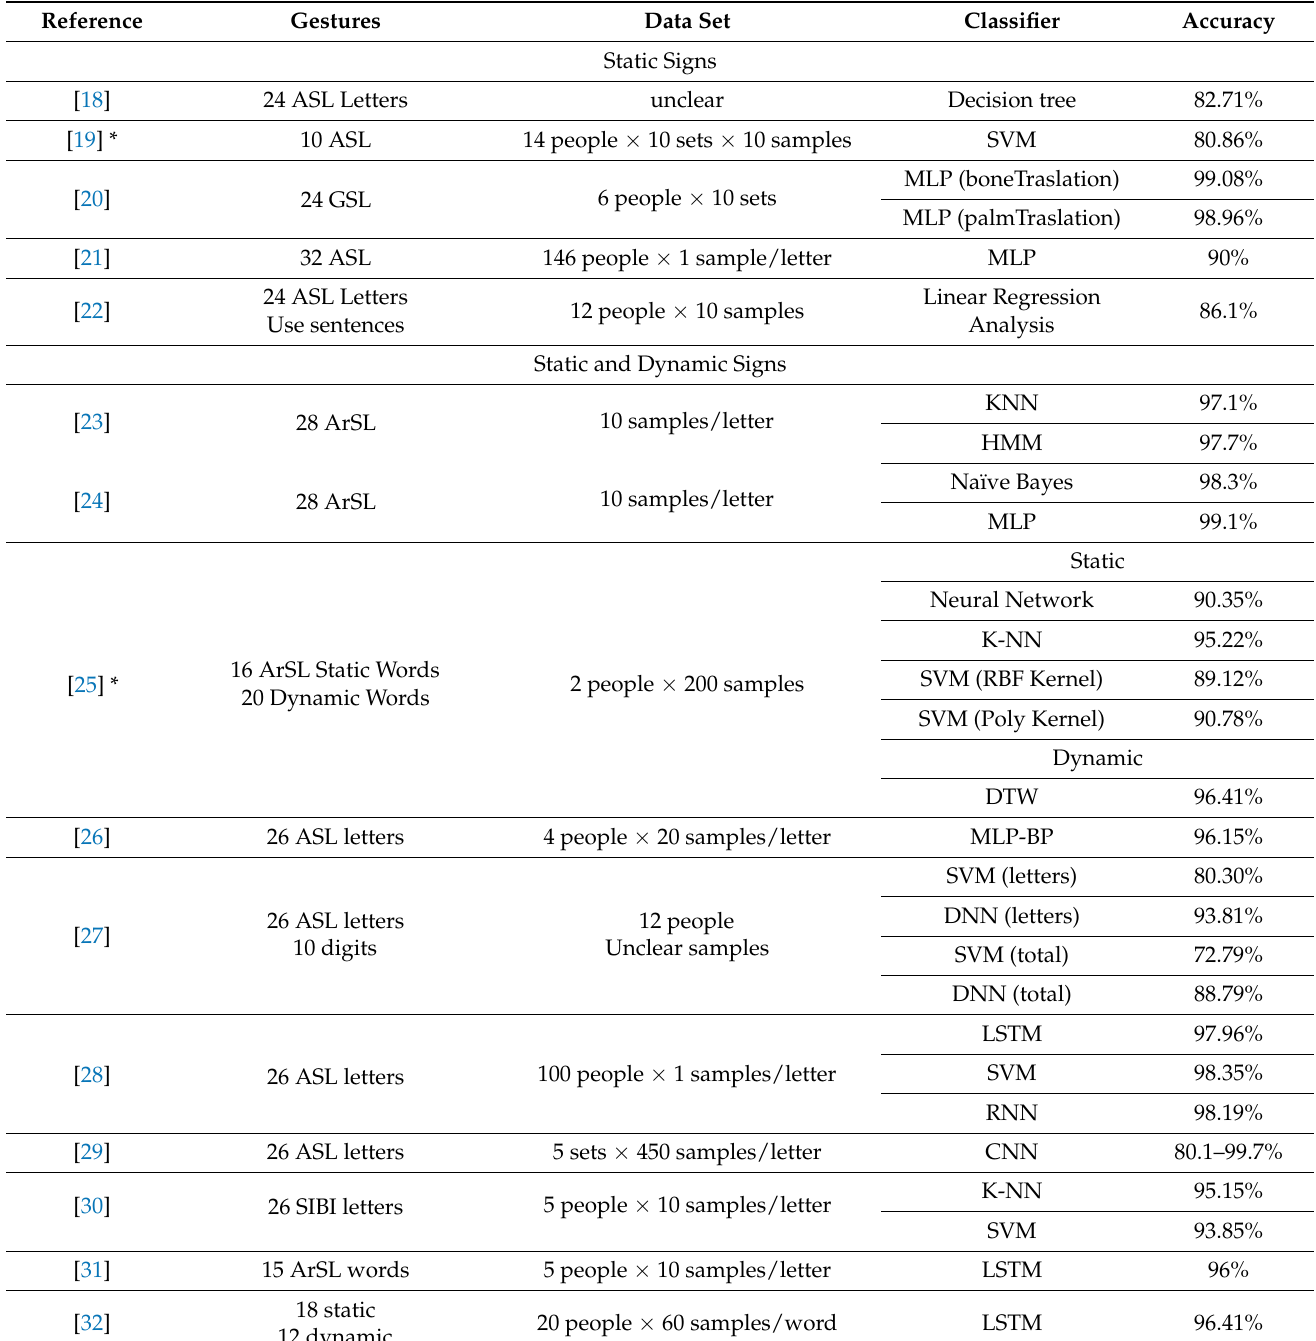
Table 5. Set of results of papers that using